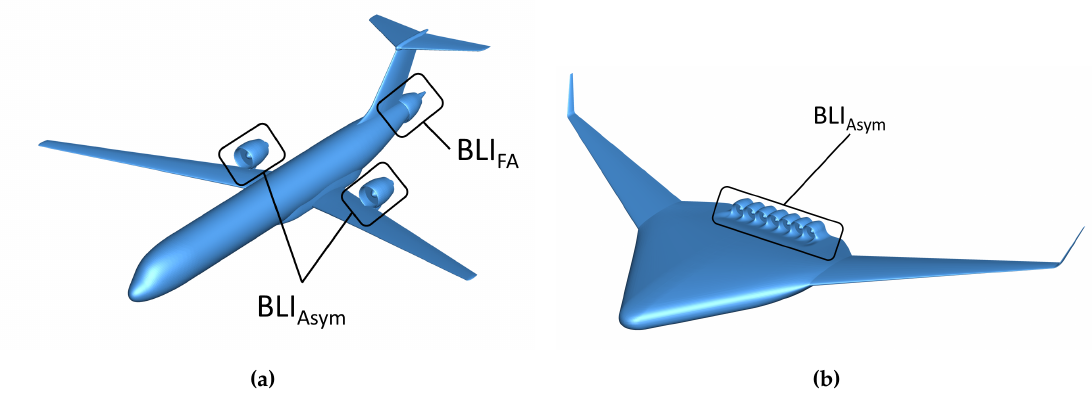
Figure 2. EWL aircraft concepts for medium and long range. ( a ) EWL medium range concept with rear mounted BLI propulsor; ( b ) EWL-BWB Concept featuring asymmetric